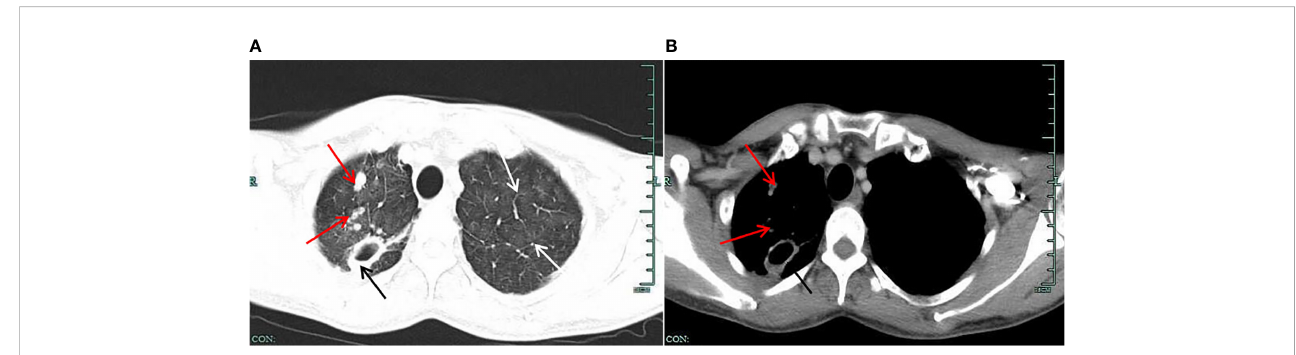
FIGURE 1 (A) Lung window on chest CT. The fi gure shows the multiple “ ground glass ” blurred shadows on both lungs (shown by the white arrow); the upper lobe of the right lung shows multiple nodular foci, one of which is larger (shown by the black arrow), showing a thick-walled cavity, and the edge of the lesion has multiple small nodule foci (shown by the red arrow). (B) Mediastinal window on chest CT. The fi gure shows a thick-walled cavity shadow (shown by a black arrow) in a larger nodular foci of the upper lobe of the right lung. The inner wall of the cavity is still smooth, the adjacent pleural traction is changed, the marginal small nodule foci are slightly displayed (shown by the red arrow), and the deposition of granular materials is